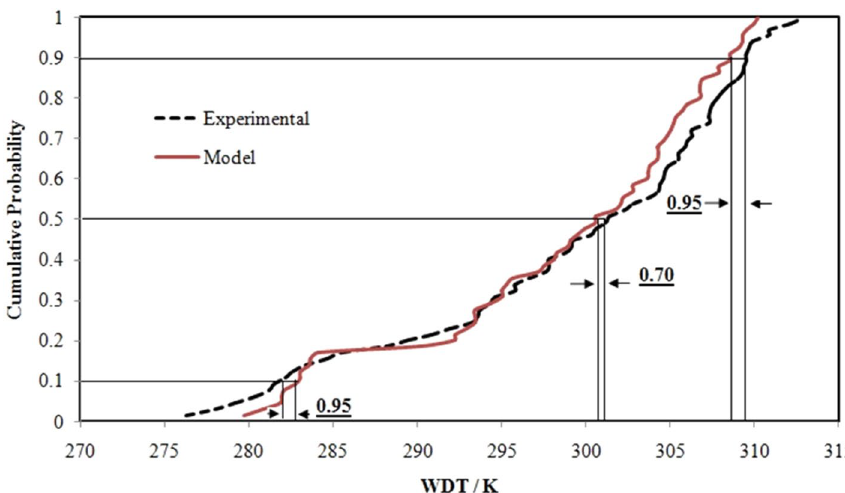
Fig. 10 Cumulative distribution functions with P10, P50, and P90